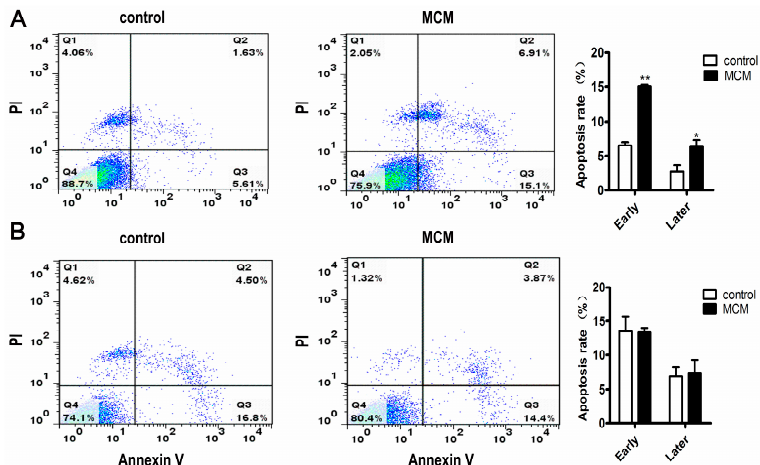
Figure 5. Flow cytometric detection and quantification of MCM-induced apoptosis in porcine s.c. preadipocytes and s.c. adipocytes. Porcine s.c. preadipocytes ( A ) and s.c. adipocytes ( B ) were cultured for three days with MCM versus physiological saline, and stained with fluorescein isothiocyanate (FITC)-labled annexin V (Annexin V-FITC) and propidium iodine (PI); then, the cell apoptosis was analyzed. n = 3, * p < 0.05, ** p < 0.01, Scale bar = 200 μ m.